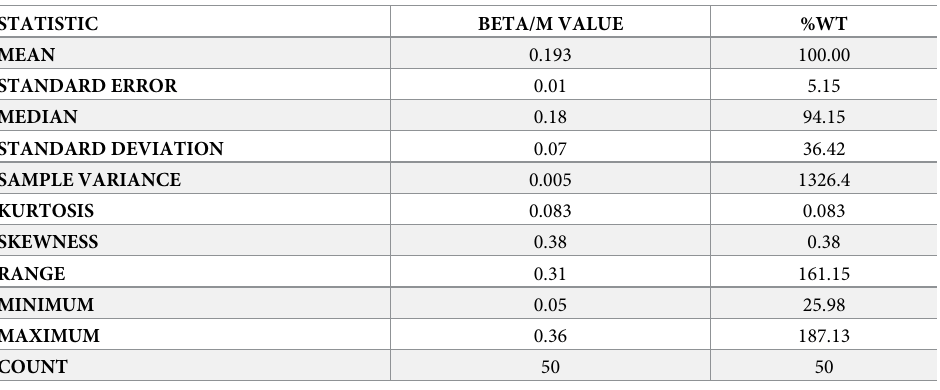
Table 2. Summary statistics for β av/M and %